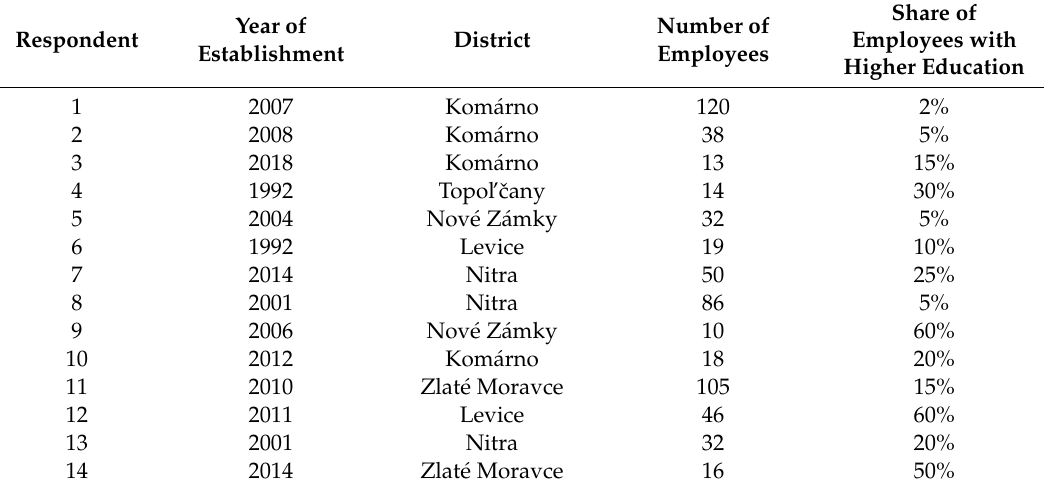
Table 3. Basic characteristics of the obtained sample of knowledge-intensive